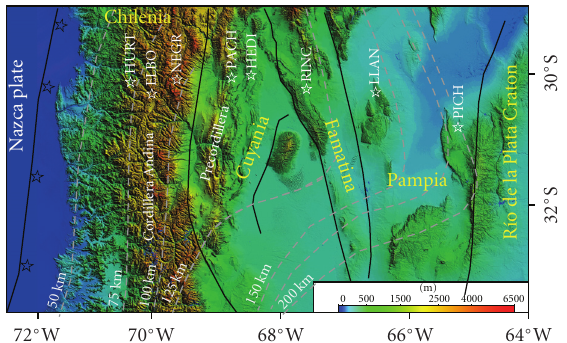
Figure 1: Geological features in the study area. The black triangles show CHARGE seismic stations. Green lines indicate terrane boundaries. Shaded areas indicate major geologic features. Grey lines indicate the contours of the depth to the top of the subducted slab by Cahill and Isacks [3]. Extracted and modified after Heit et al. [11].